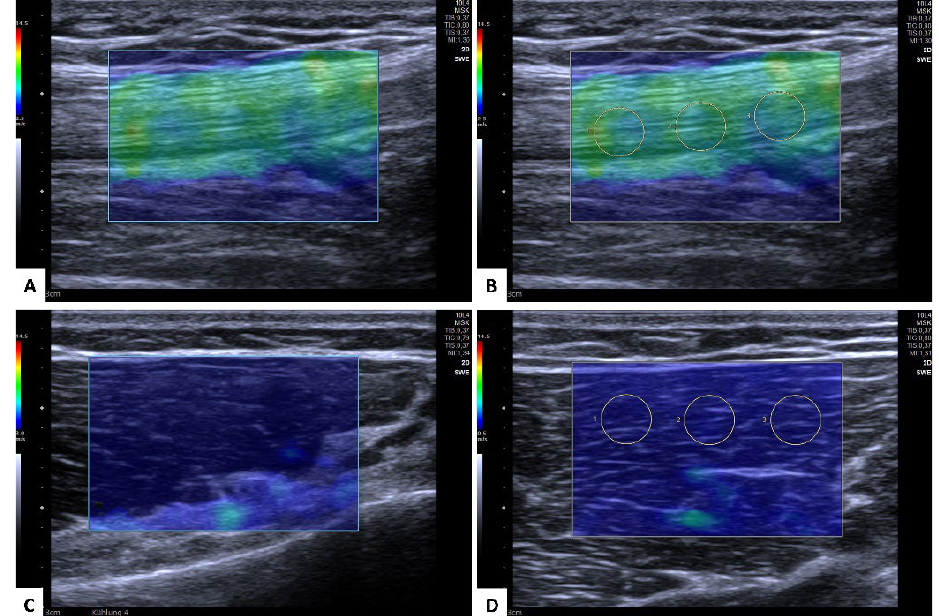
Figure 2. Shear wave elastography of the quadriceps tendon ( A , B ) and medial vastus muscle ( C , D ) with color-coded map ( A , C ) and assessment of shear wave speed using three ROI-measurements per image ( B , D ). The color scale on the left side of each image can be used for interpretation of the shear wave speed, ranging from minimum 0 m/s (e.g., very soft = blue) to a maximum of 15 m/s (e.g., red = stiff). In this example, the tendon stiffness is visualized green (resulting in a moderate stiffness around 2–3.5 m/s; Figure 1A,B), while the softer muscle tissue ranged around 1 m/s and is therefore visualized as blue (Figure 1C,D).